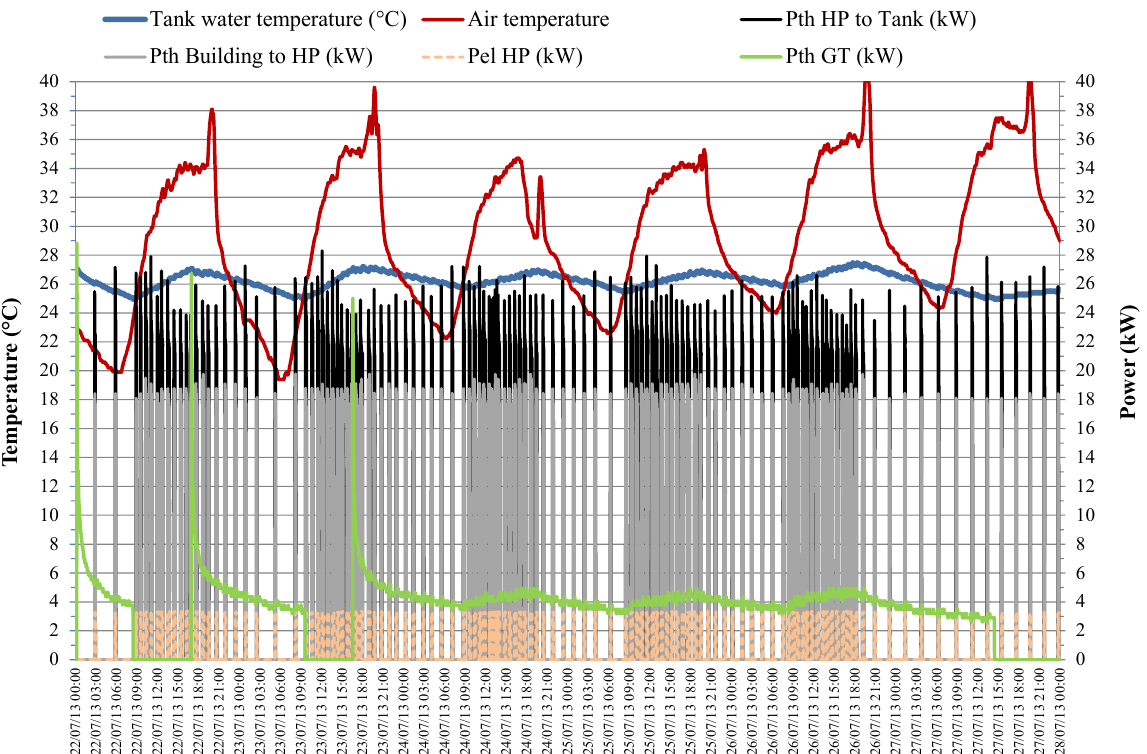
Figure 6. Cooling working cycle: the power dissipated by the borehole [Pth geothermal (GT)], the thermal power pumped into the tank [Pth heat pump (HP) to take], taken off the building (Pth HP from building), and the electric power absorbed by the HP (Pel HP) are